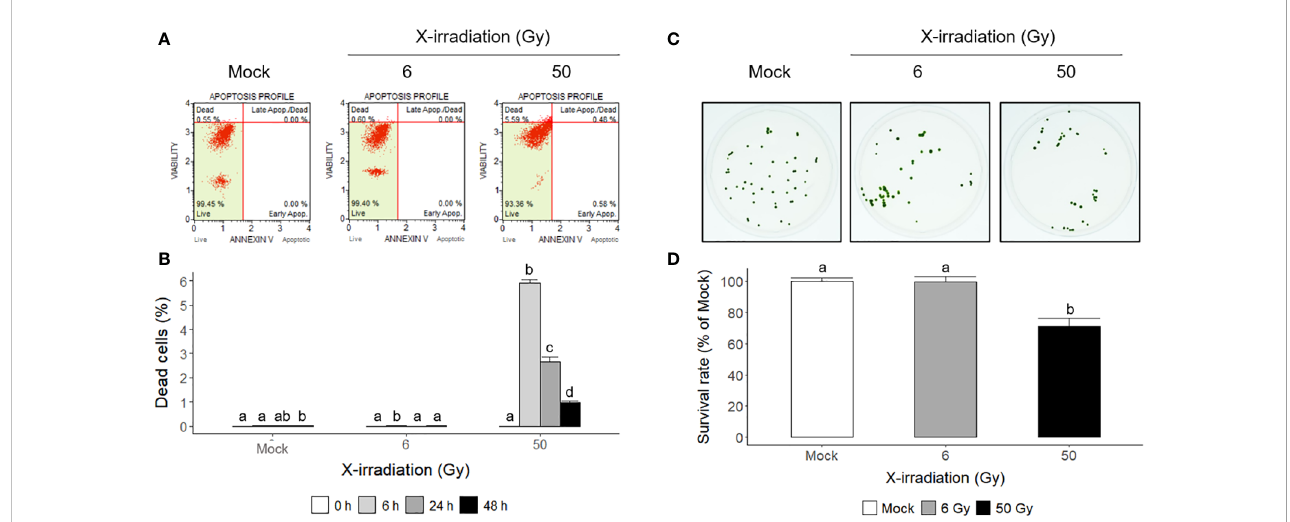
FIGURE 4 Apoptotic cell death and survival rates of C. reinhardtii cells after X-irradiation with 6 or 50 Gy. (A, B) The proportions of apoptotic and necrotic dead cells determined by fl ow cytometry at 6 h or during 48 h after X-irradiation with 6 or 50 Gy; (C, D) the survival rates of X-irradiated cells relative to the mock 7 days after X-irradiation with 6 or 50 Gy. In (B, D) , the data represent the mean ± standard error (SE) with n = 3 (5,000 cells for each) or n = 12 from three or four independent experiments, respectively. Different letters indicate signi fi cant differences at p < 0.05 (one-way analysis of variance followed by Tukey ’ s honestly signi fi cant difference test).